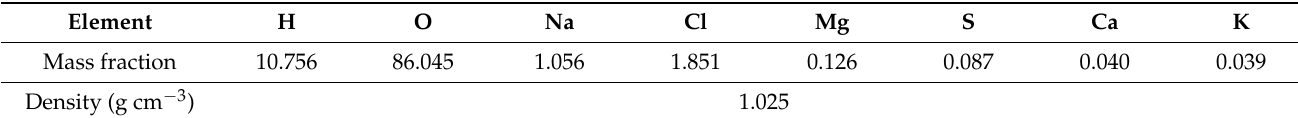
Table 3. Elemental composition and density of seawater used in simulation